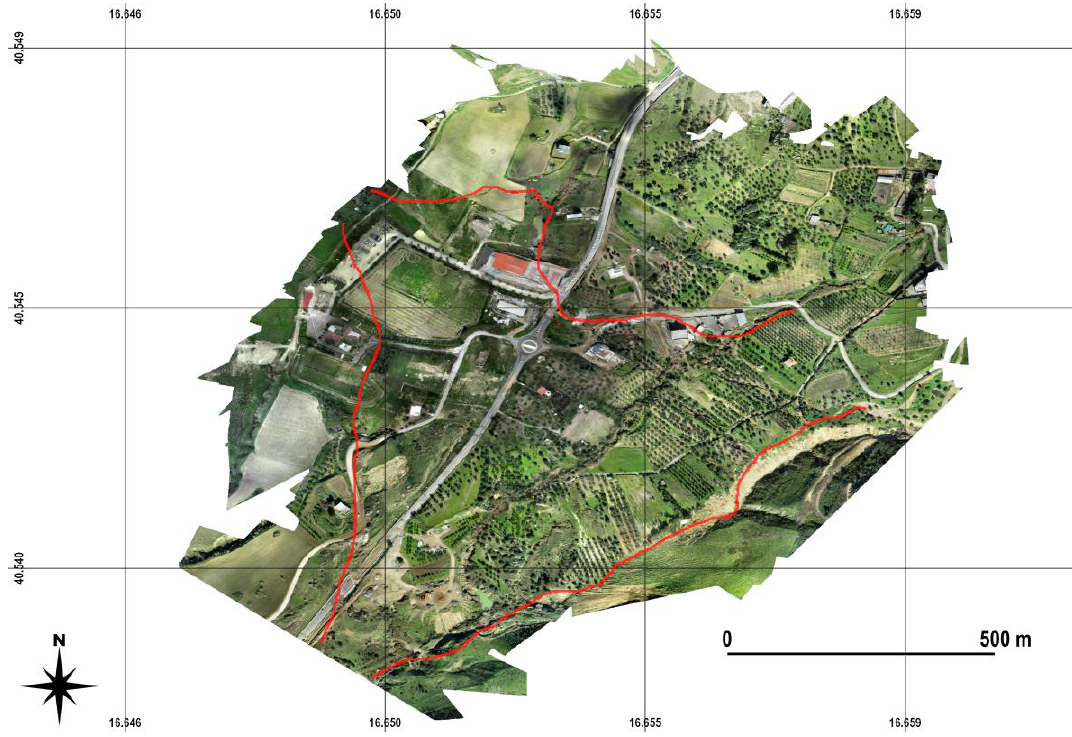
Figure 3. Orthophoto of the Montescaglioso landslide obtained by the UAV surveys. The red lines represent the planar outline of the landslide body.